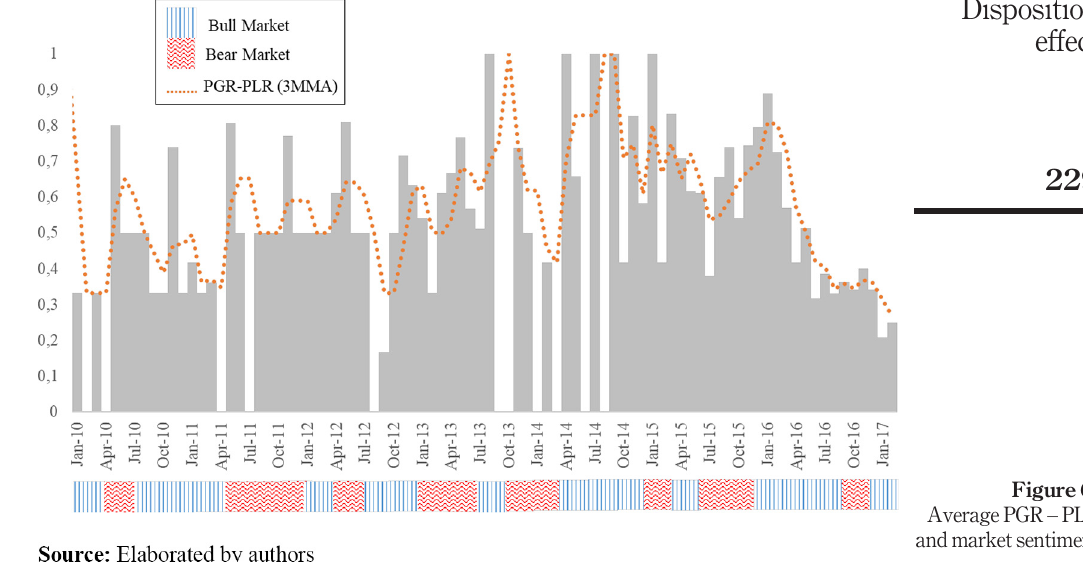
Figure 6. Average PGR –